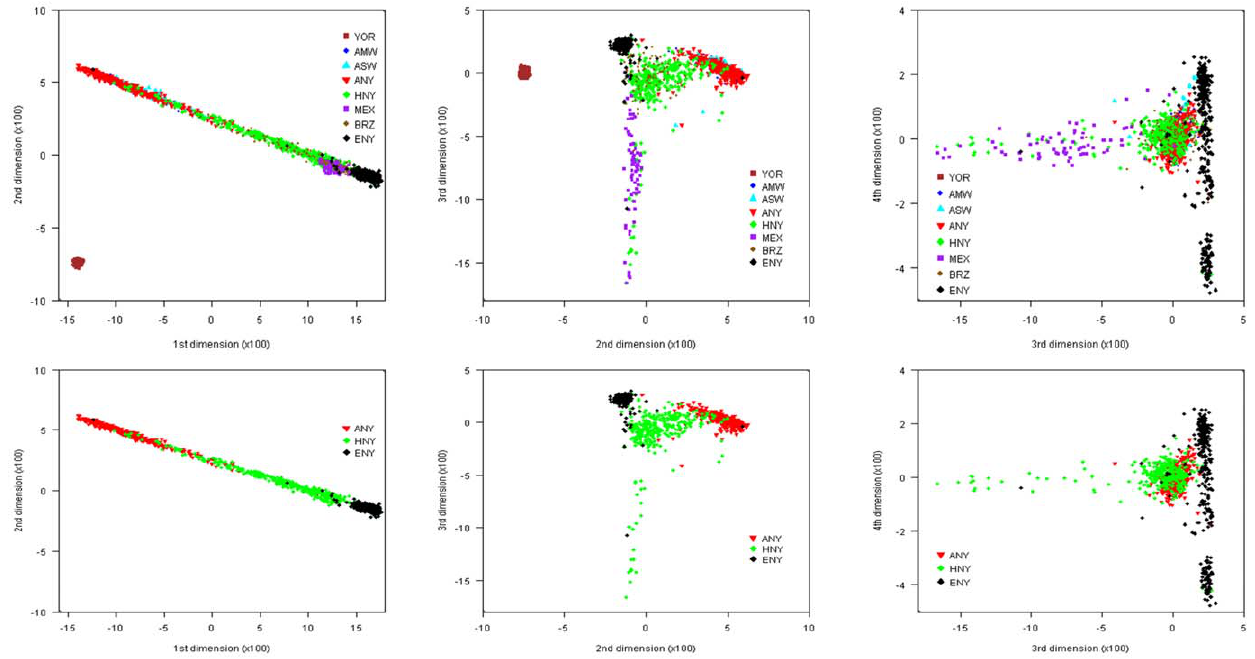
Figure 1. Multidimensional scaling plots for all samples (TOP) and only biobank samples (BOTTOM). Plots of subjects in the 1 st and 2 nd dimensions (left column), 2 nd and 3 rd dimensions (middle column), and 3 rd and 4 th dimensions right column). Abbreviation for samples: African American biobank sample (ANY); European American biobank sample (ENY); Hispanic American biobank sample (HNY); African ancestry in Southwest USA (ASW); Mexican ancestry in Los Angeles, California (MEX); Yoruba from Nigeria (YOR); African American from Maywood, Illinois (AMW); Brazilians from Brazil (BRZ). doi:10.1371/journal.pone.0019166.g001 PLoS ONE |